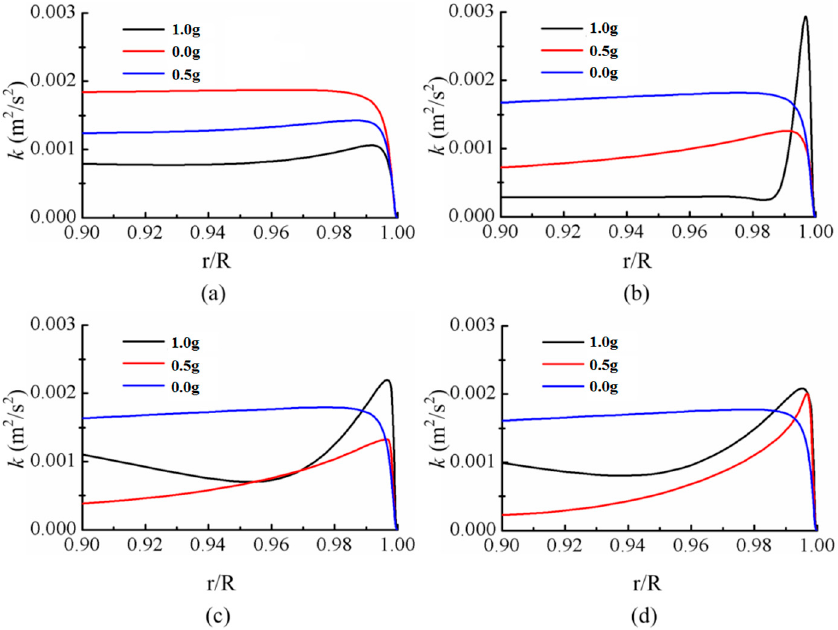
Figure 25. Distribution of the turbulent kinetic energy in different sections: ( a ) x/D = 13; ( b ) x/D = 26; ( c ) x/D = 39; ( d ) x/D = 53.